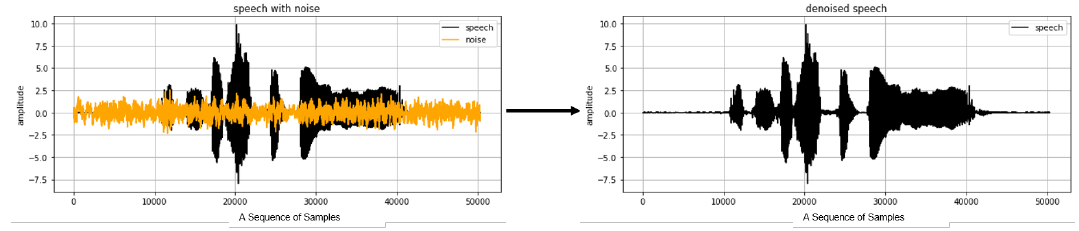
Figure 1. Denoising of speech